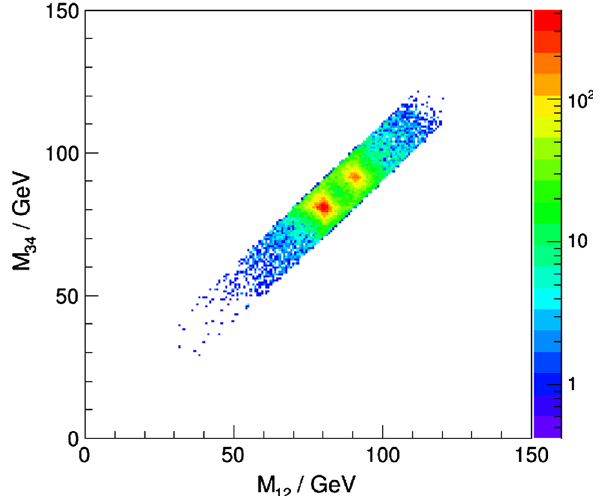
Fig. 11 TheGenJetleveldistributionof M 12 versus M 34 withtheequal mass condition. The selection efficiency for WW/ZZ is 59%/47%